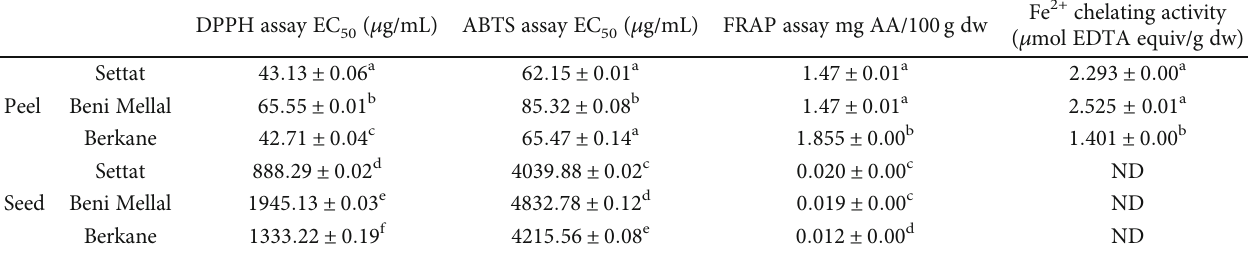
Table 2: Antioxidant activities of pomegranate peel and seed.